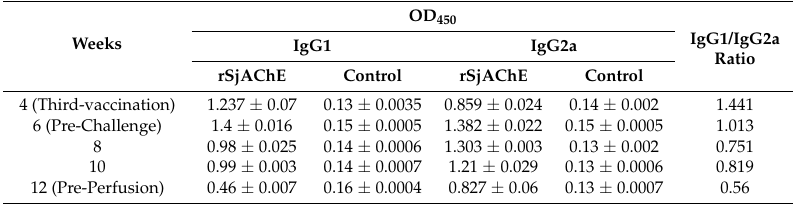
Table 2. IgG1 and IgG2a immune profile in mice induced by vaccination with recombinant SjAChE and challenge of S.